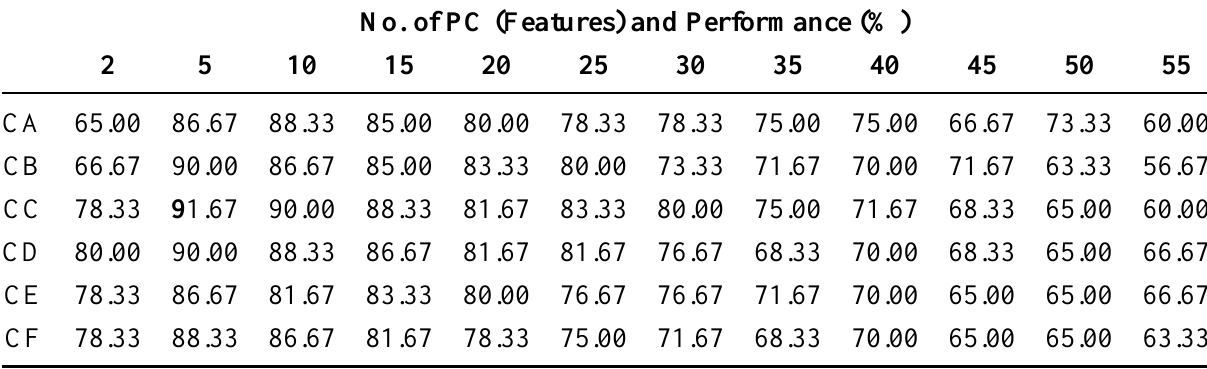
Table 7. Oil palm FFB ripeness classification accuracy for method